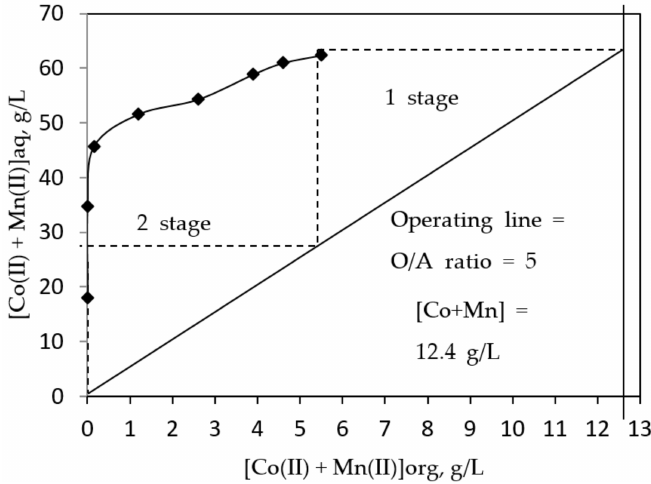
Figure 5. McCabe-Thiele diagram for Co and Mn stripping by 2 M HBr.